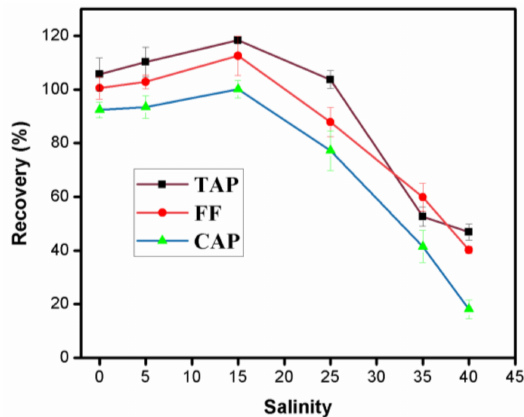
Figure 4. Effect of salinity on recovery ( n = 3). Conditions: Concentration of analytes, 5 ng/mL; V MeOH /V FA , 97:3; Volume of eluent, 15 mL; Flow velocity, 0.5 mL/min; Sample pH,